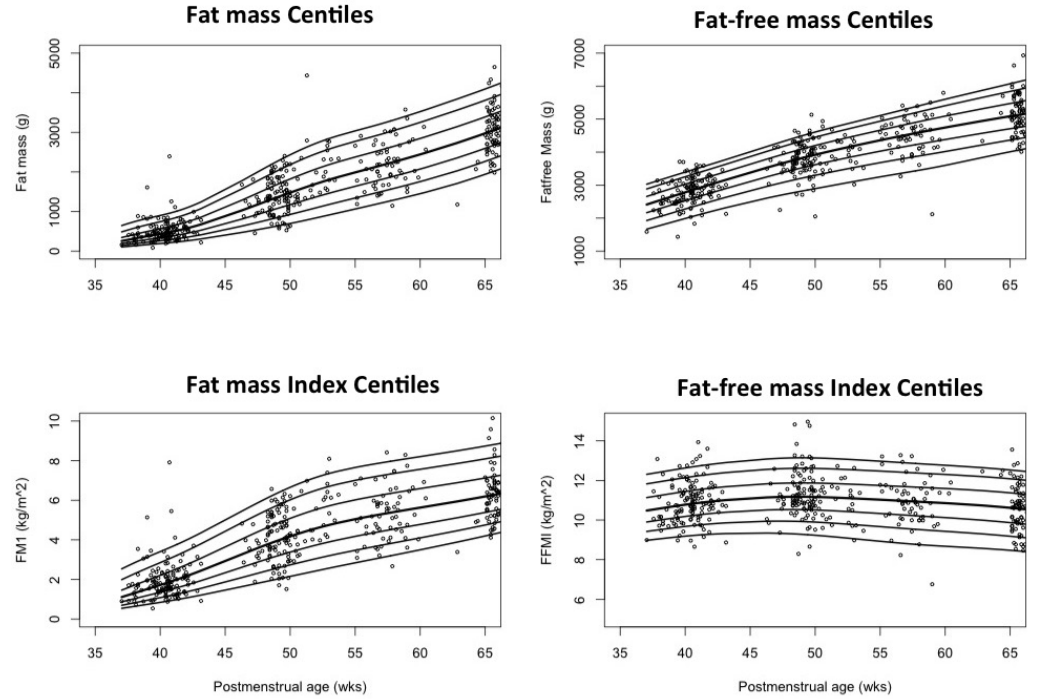
Figure 5. Growth curves showing 3rd, 10th, 25th, 50th, 75th, 90th, and 95th centiles for term infants constructed from imputed dataset.